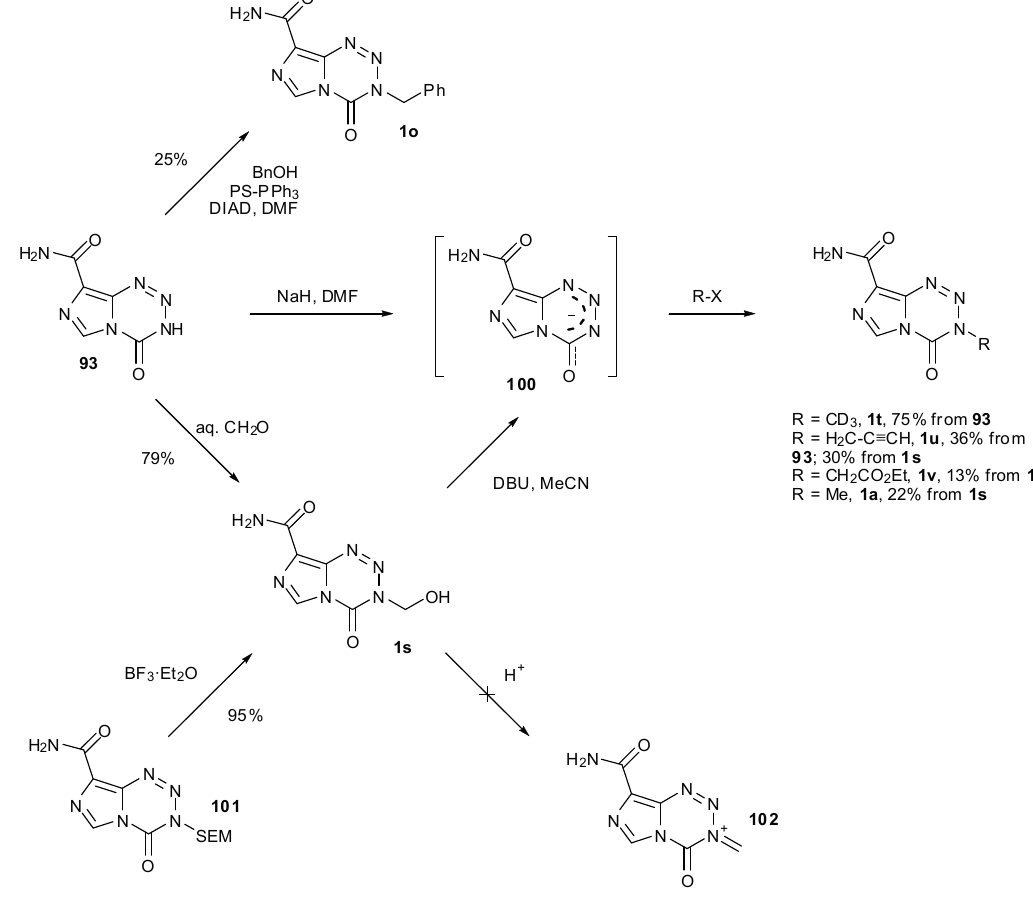
(e.g., 1w and 1x ) has demonstrated MGMT- and MMR-independent activity; several cell lines that